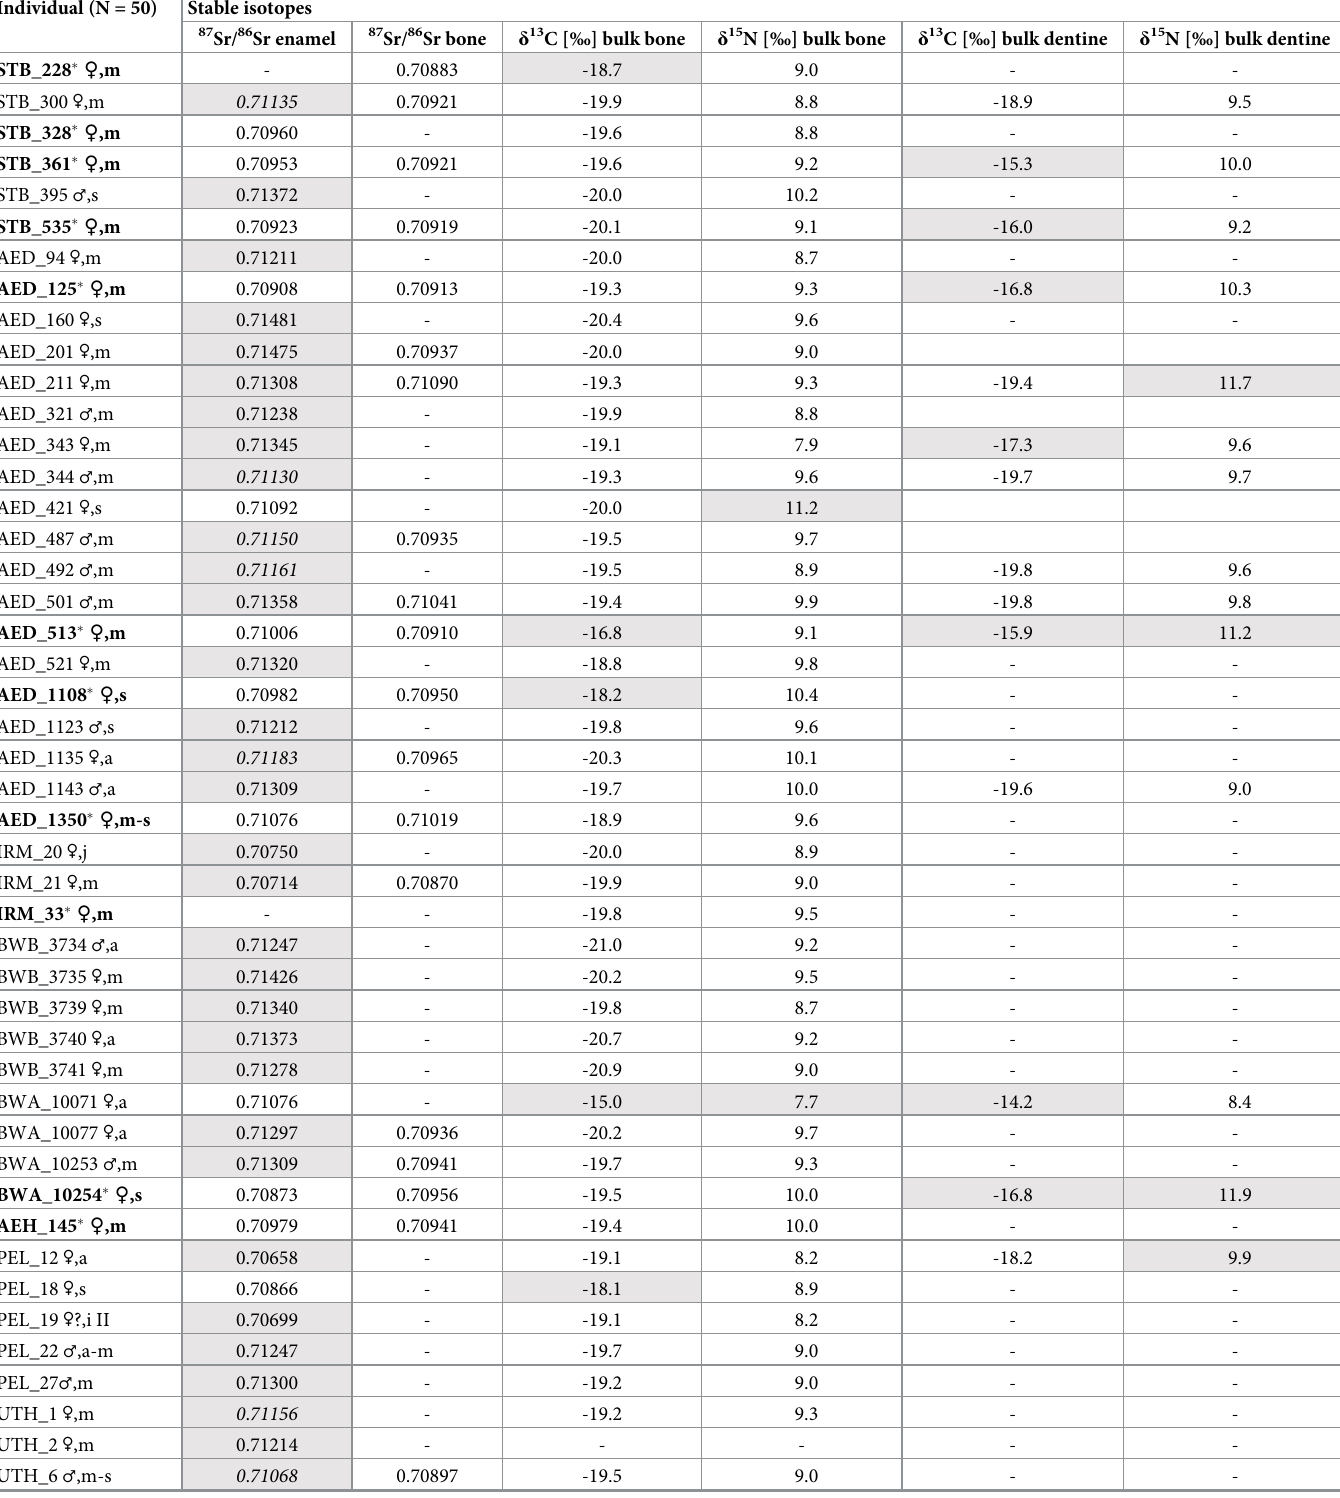
Table 2. Characteristics of assumed newcomers according to deviating isotopic ratios or presence of ACD. Individual (N =